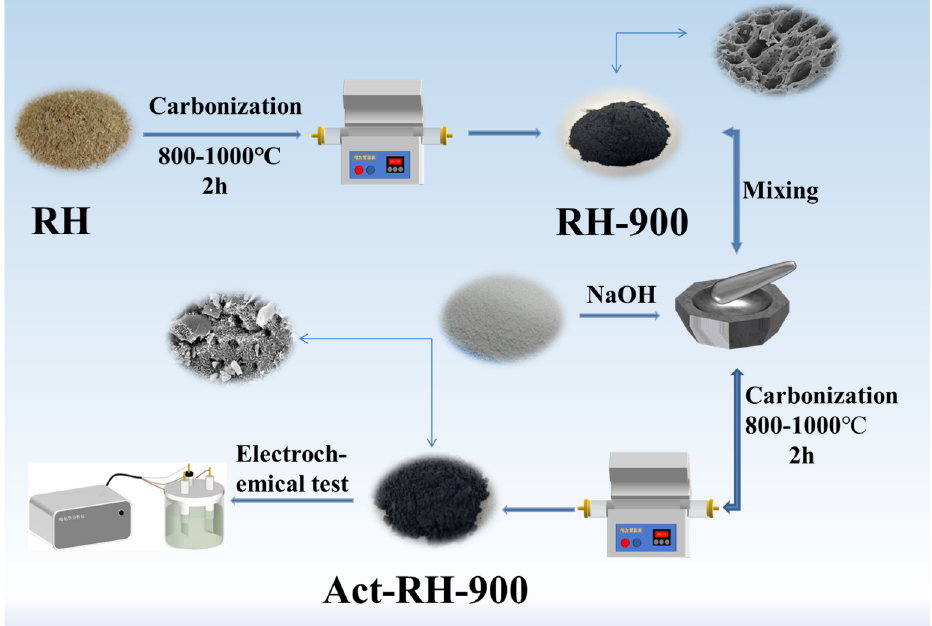
Figure 1. The schematic cartoon of samples.